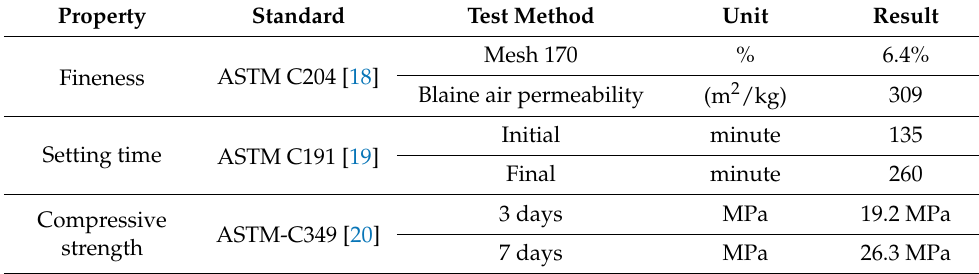
Table 2. Physical properties of cement.